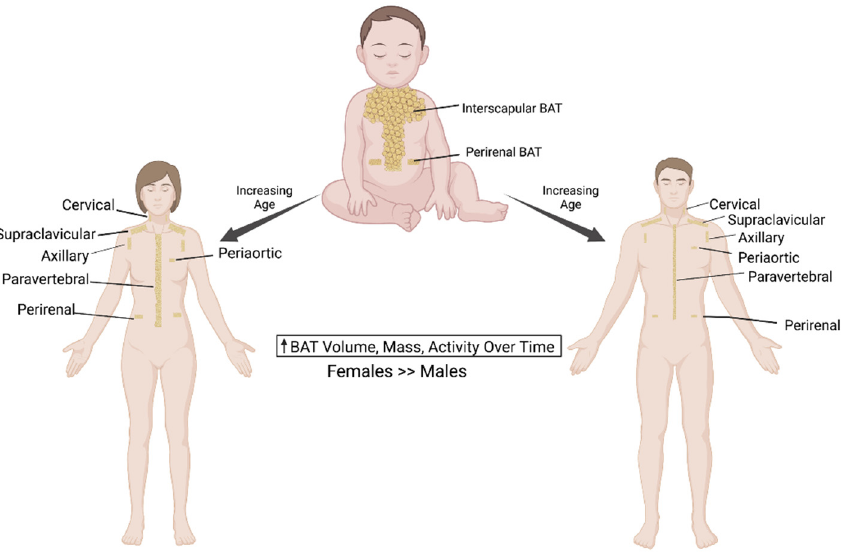
Figure 1. BAT distribution in infants, women and men. BAT is stored in a separate interscapular depot in infants, and they lose their brown adipose tissue as they age. In adult humans, most brown adipocytes can be found in the supraclavicular BAT depots in the neck region. Lesser amounts of BAT are found across the aorta, vertebrae, axillary and kidney areas. There is a similar distribution of brown adipose tissue in both women and men. However, women have a greater amount of BAT mass and